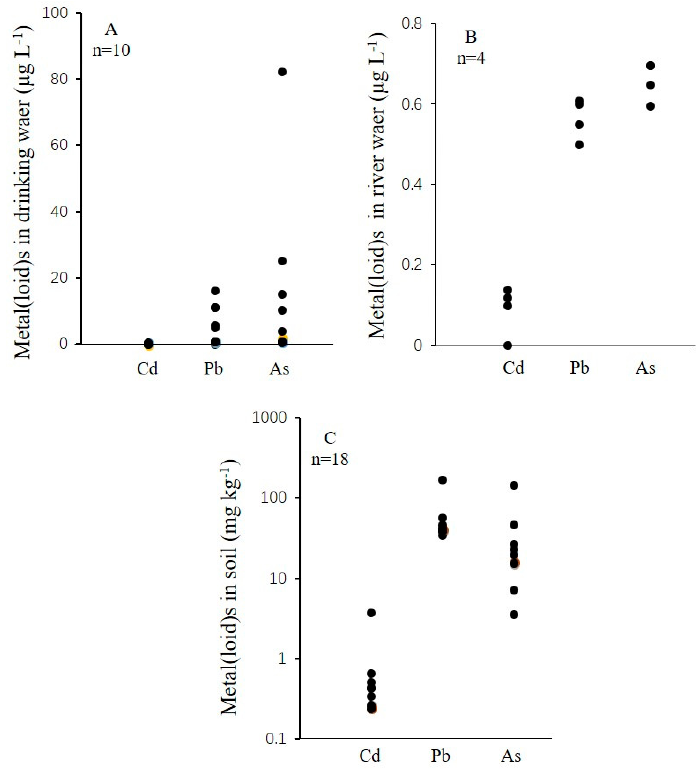
Figure 2. Cd, Pb and As concentrations in drinking water ( A ), river water ( B ) and soil samples ( C )